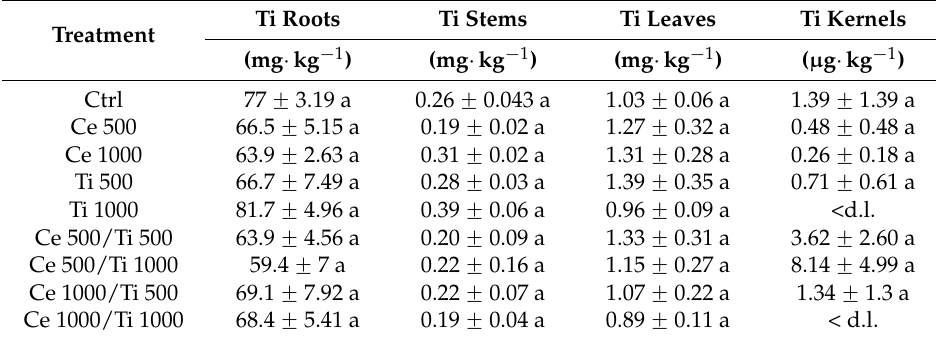
Table 3. Ti concentration observed in roots, stems, leaves and kernels of barley grown in control soil and n CeO 2 and n TiO 2 -amended soil. Values are mean ˘ S.E. ( n = 5). Same letters indicated no statistical difference between treatments at Tukey’s test ( p ď 0.05). d.l. = detection